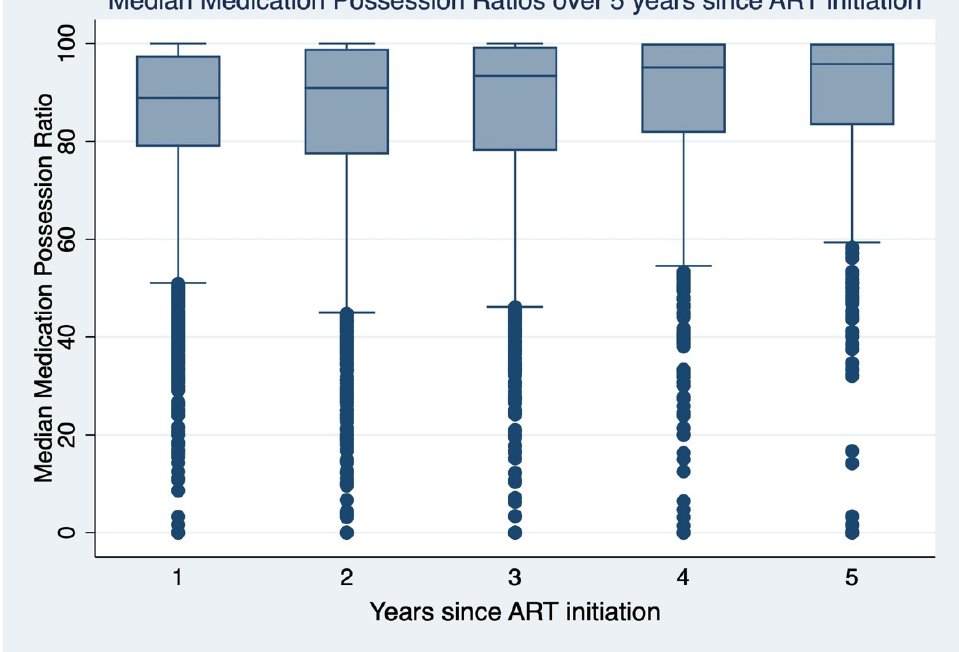
Figure 1. Trends of the median medication possession ratio over the years since ART initiation. Factors associated with good MPR among adolescents and young adults with HIV on ART are summarized in Table 2. In a univariate logistic regression analysis, male sex, being virologically suppressed, and being enrolled in 2018 or 2019 were significantly associated with good MPR. However, having age between 20 and 24 years, baseline CD4 count of >500 cells/mm 3 , having WHO stage II or III, and being on an efavirenz-based regimen were associated with reduced good MPR. In multivariate analysis, we adjusted for sex, CD4 count, enrollment year, WHO stage, number of pills, viral load, and regimen combination. Factors that remained significantly associated with MPR were sex, WHO stage, CD4 count, virological suppression, and year of enrollment. The odds of having good MPR among males was 30% higher compared with female counterparts (aOR 1.3; 95% CI 1.1–1.5; p -value = 0.002). Compared with individuals with WHO stage I at baseline, the odds of having good MPR was 30% more likely for those with WHO stage II (OR 1.3; 95% CI 1.1–1.5; p -value < 0.001) and 60% more likely for those with WHO stage III (OR 1.6; 95% CI 1.3–1.9; p -value < 0.001). Similarly, having a baseline CD4 count of >500 cells/mm 3 compared with CD4 count <200 cells/mm 3 was associated with 30% lower odds of having good MPR (aOR 0.7; 95% CI 0.6–0.9; p -value < 0.009). Being enrolled in 2018 was associated with 30% increased odds of good MPR (OR 1.3; 95% 1.1–1.5; p -value = 0.017), while being enrolled in 2019 was associated with 50% increased odds of good MPR (OR 1.5; 95% 1.2–1.9; p -value = 0.001) compared with 2015. Having